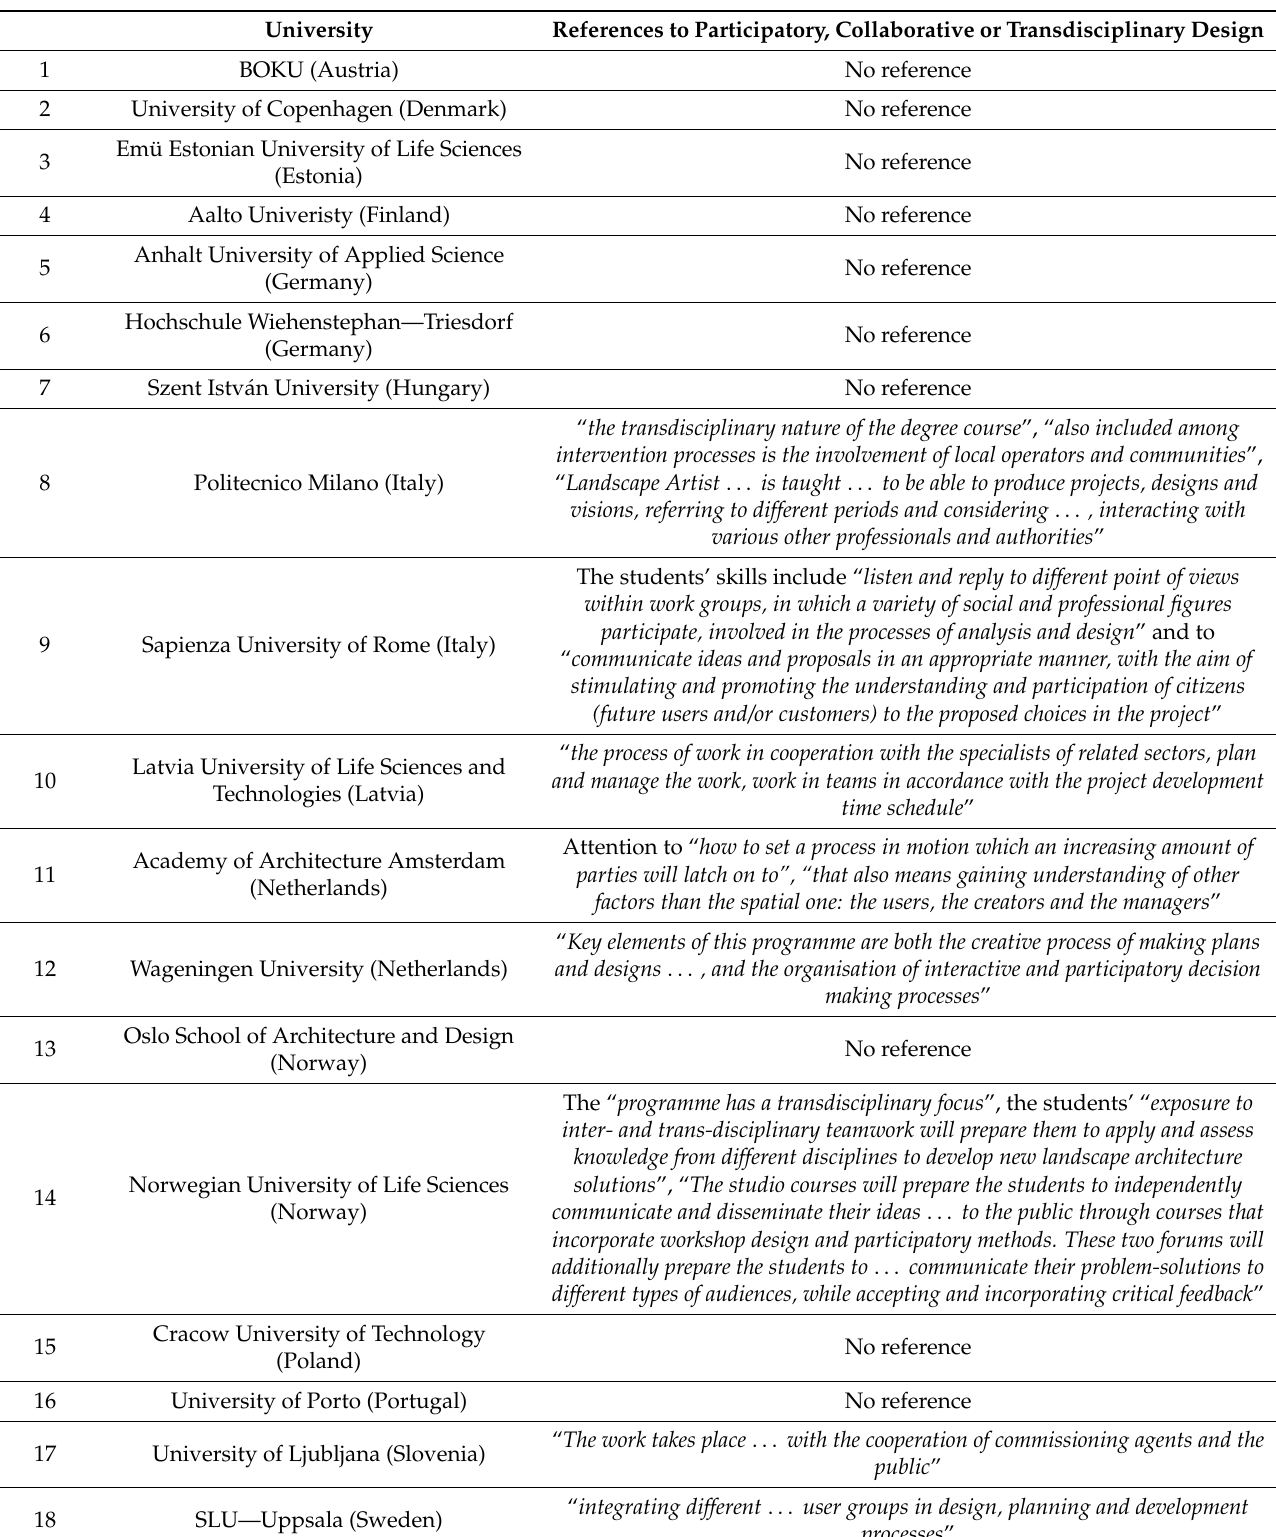
Table 2. Participatory, collaborative, and transdisciplinary design in the program